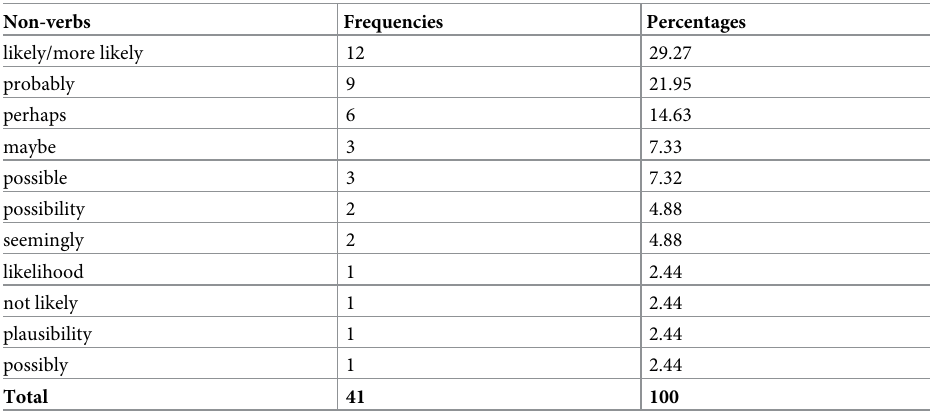
Table 17. Frequencies and percentages of